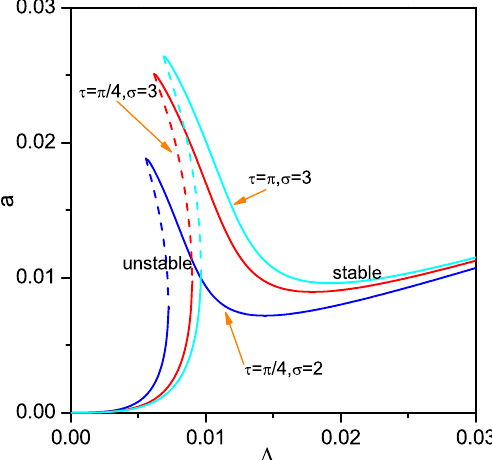
Figure 6. The response-excitation amplitude curve of the superharmonic resonance.